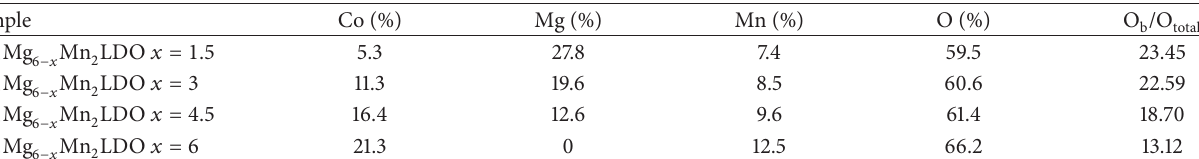
Table 2: The amount of the surface elements of Co 𝑥 Mg 6−𝑥 Mn 2 LDO.